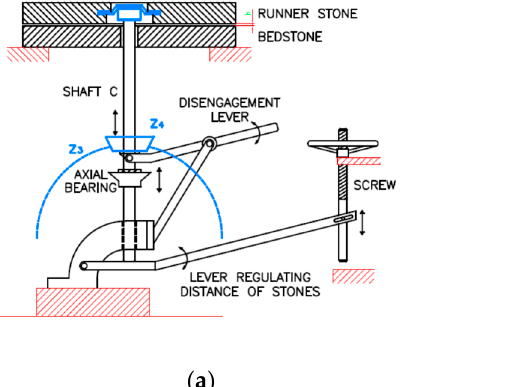
Figure 16. Mechanical scheme of the runner stone engagement lever and of the stones distance regulation mechanism (Riviera mill): ( a ) Runner stone engaged; ( b ) runner stone disengaged.